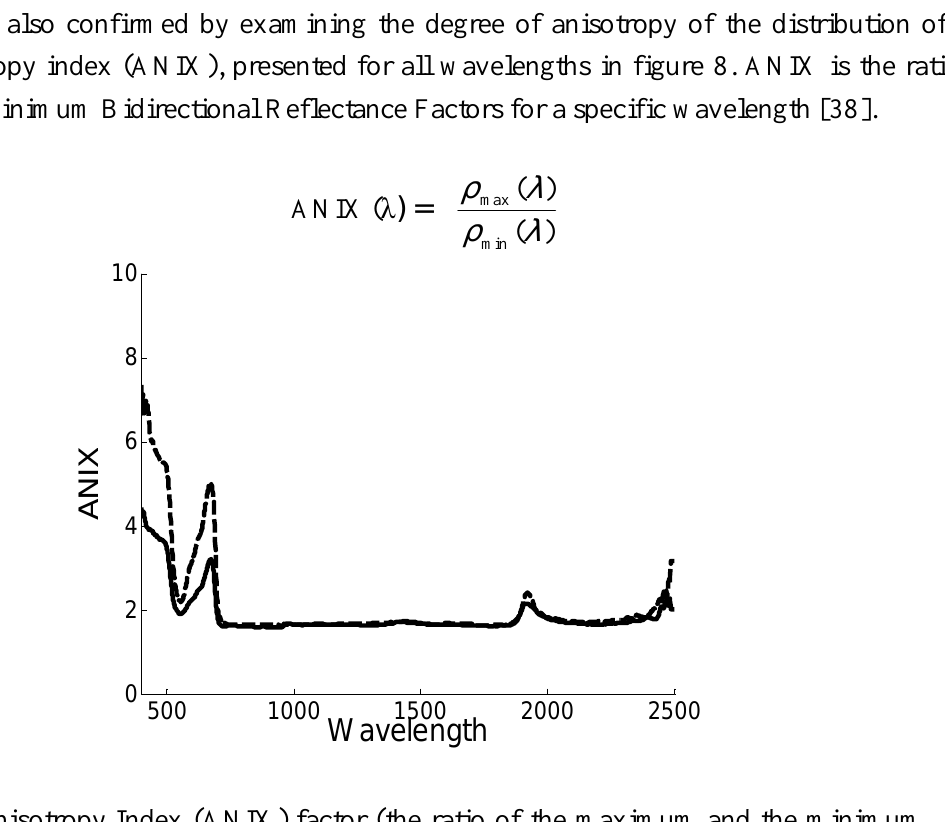
Figure 8 . Anisotropy Index (ANIX) factor (the ratio of the maximum and the minimum Bidirectional Reflectance Factor for a specific wavelength) for a Fagus sylvatica L. leaf is presented at all wavelengths between 400 nm and 2500 nm, for light source position set at 0° azimuth and 30° zenith (solid line) and at 0° azimuth and 60° zenith (dotted